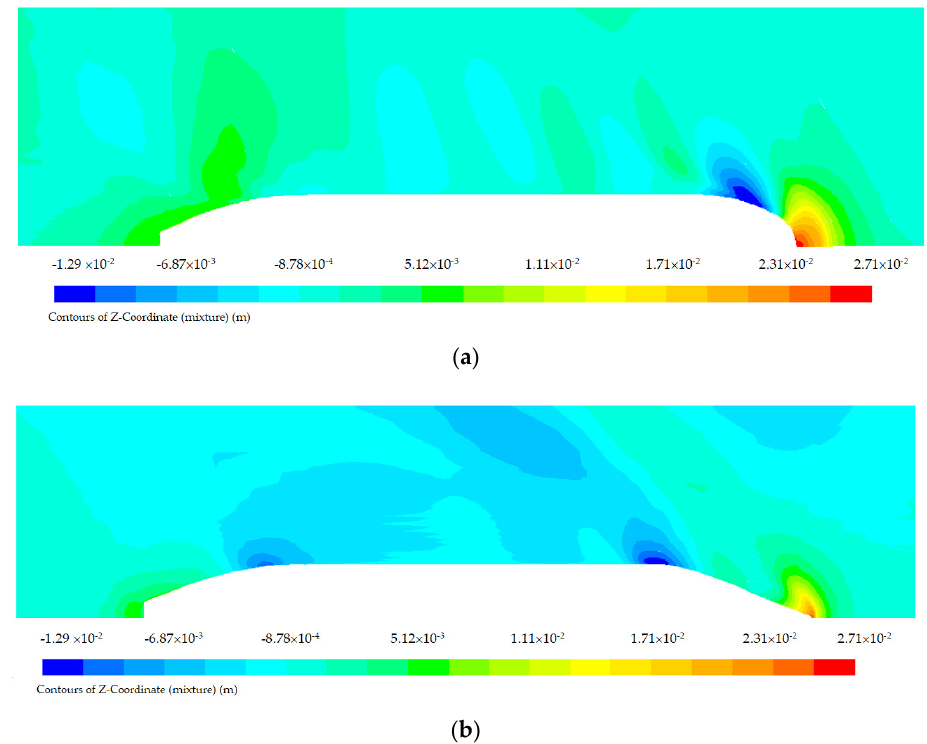
Figure 7. Simulated wave pattern at the free surface of the ships at F n = 0.163 in calm water conditions. ( a ) The NBS with a blunt bow shape; ( b ) the new hull with a newly developed bow shape.